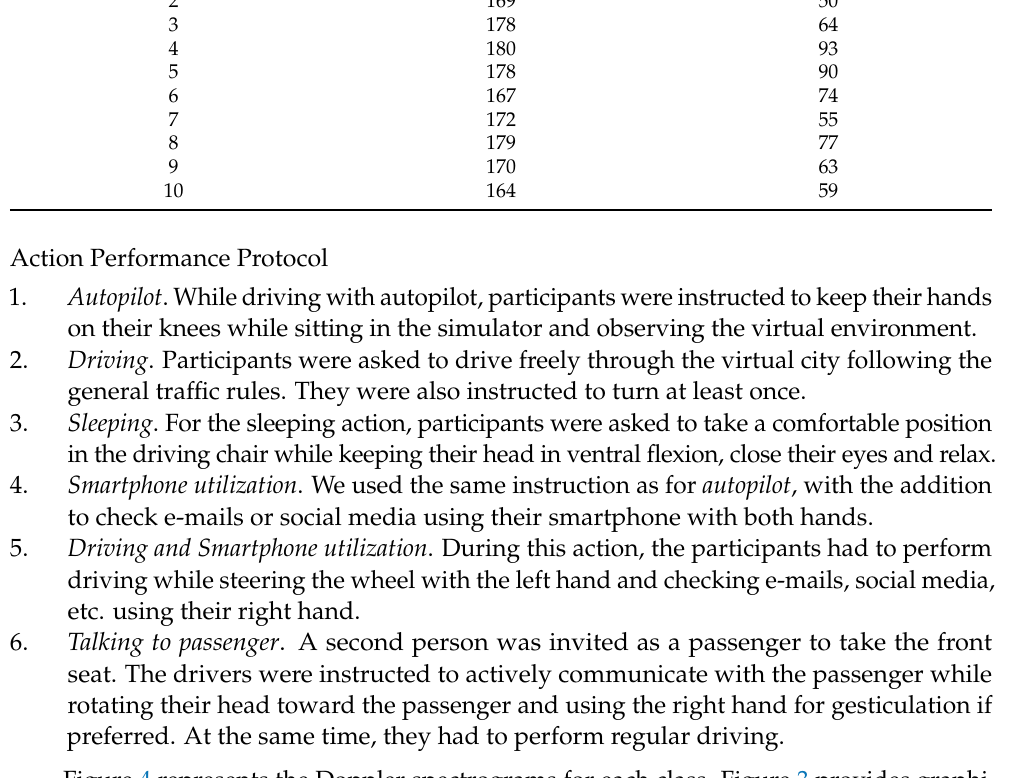
( c ) Sleeping ( d ) Smartphone utilization ( e ) Driving & Smartphone utilization ( f ) Talking to passenger Figure 4. Range-Doppler spectrograms of six ( a – f ) in-cabin activities captured by the radar. Three images within one class represent roughly one second.